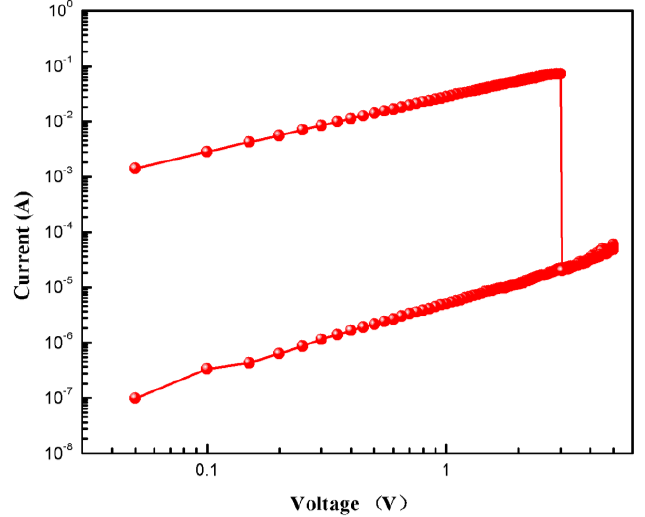
Figure 7. I-V characteristics of Al / Bombyx mori body fluid film / ITO biomemristor in double natural logarithmic coordinates.